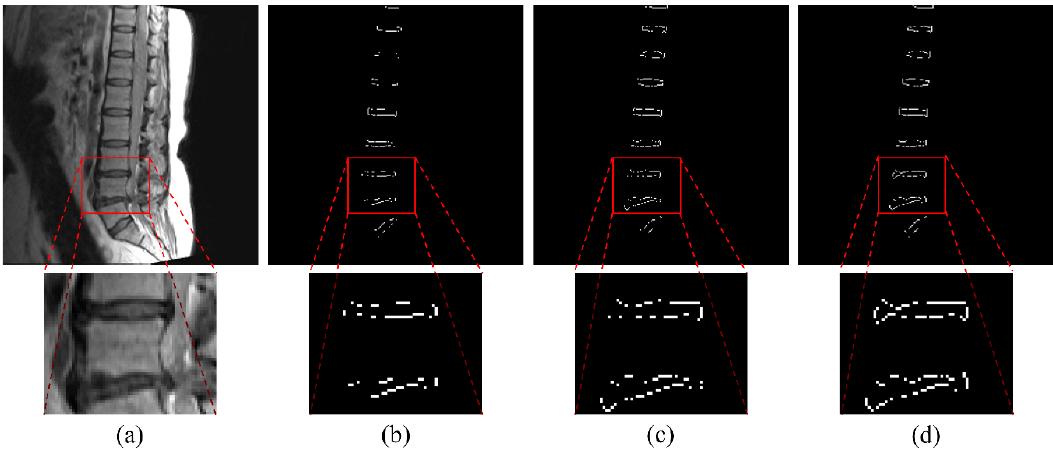
Figure 8. Segmentation results. ( a ) Input MR spine image. ( b ) Boundary segmentation result from U-net. ( c ) Boundary segmentation result from cascaded U-net. ( d ) Boundary segmentation result from BSU-net. White pixels correspond to boundary pixels that were perfectly matched with true boundary labels. BSU-net preserved more boundaries than other models.